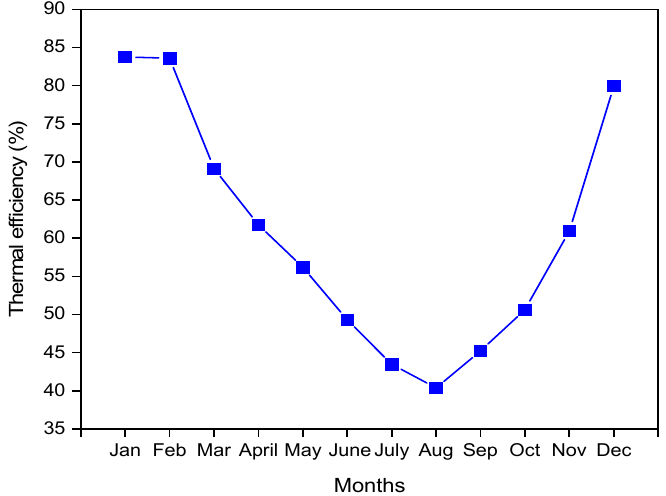
Figure 6. Thermal efficiency of the system using selected working fluids. The curve in Figure 7 represents the mass fraction x of fluid 1 and the water heating power used for heating water in the WHS. The shapes of both graphs are similar because the power utilised by the WHS is proportional to the mass fraction x of fluid 1 that heats water in the system. The mass fraction ‘x’ is an input variable based on hot water demand by residents; therefore, it is higher in winter and less in summer. The water heating system consumes more power in winter than in summer.